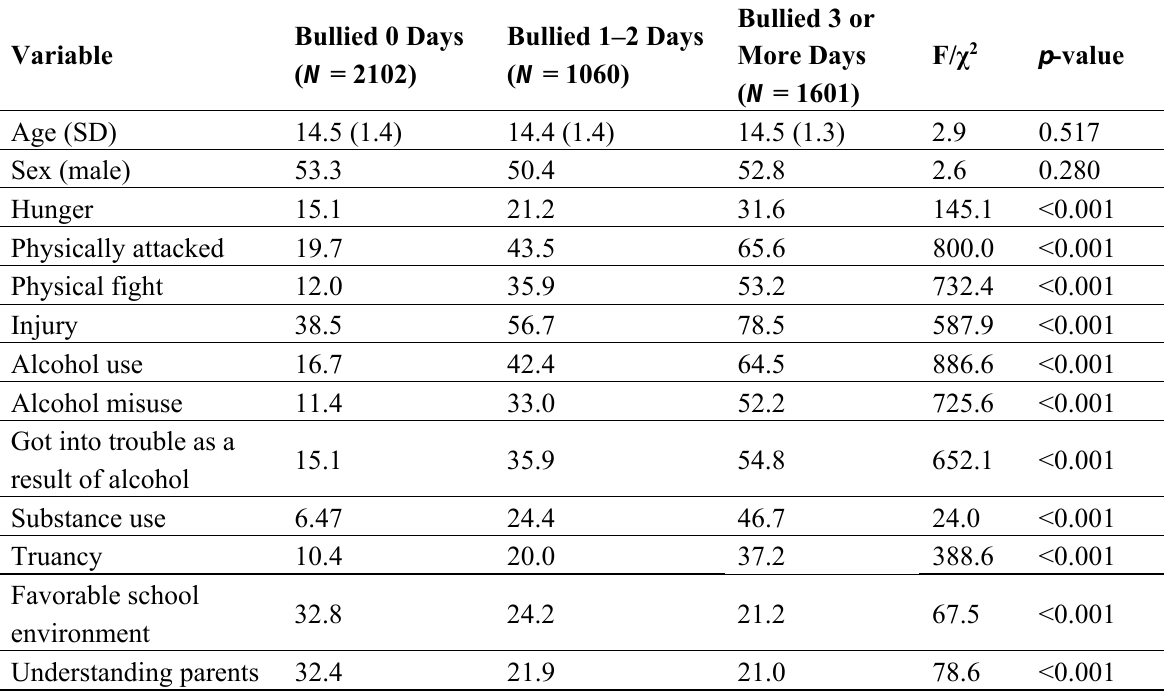
Table 2. Distribution of selected factors according to categories of bullying among school-attending adolescents in